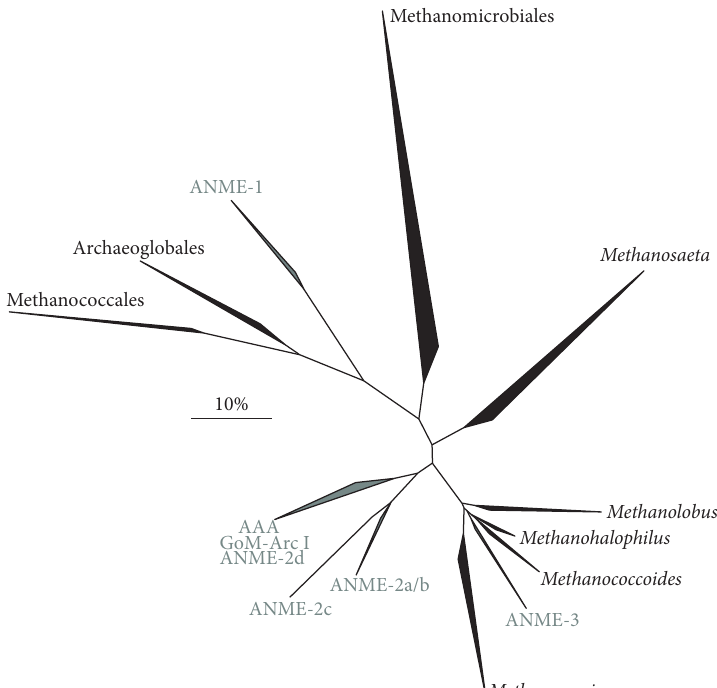
Figure 1: Phylogenetic tree of full length archaeal 16S rRNA sequences showing all methanotrophic clades so far described (grey) and other archaeal clades used in our domain based (meta)genome comparison (black). The tree was constructed with the ARB software package (version arb-6.0.1.rev12565) [49] using 2800 sequences from the SILVA SSURef NR 99 database (release 119.1) [50]. Trees were calculated by maximum likelihood analysis (RAxML, PHYML) and the ARB neighbor-joining method with terminal filtering and the Jukes-Cantor correction. Resulting trees were compared manually and a consensus tree was constructed. Sulfolobales as outgroup was removed after tree calculations. The scale bar represents the percentage of changes per nucleotide position.